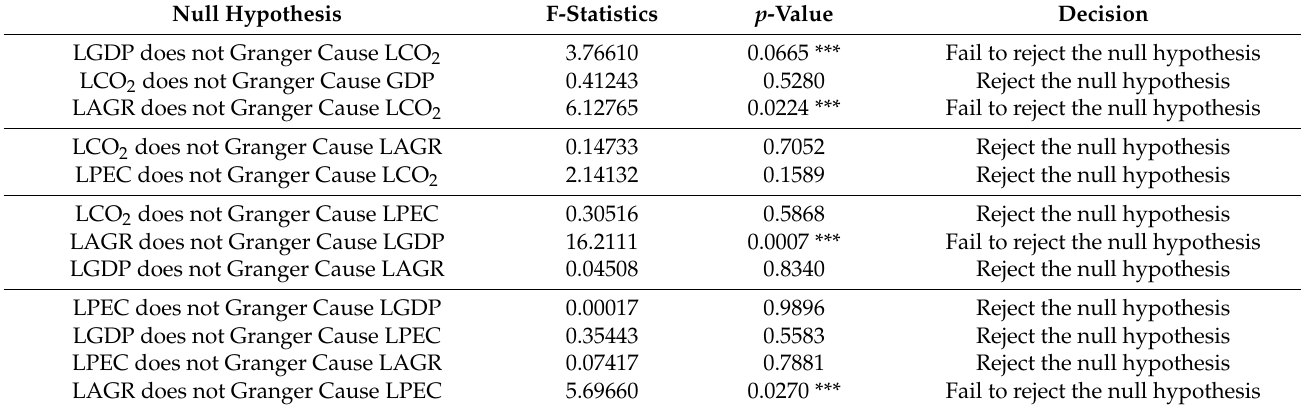
Table 6. Pairwise Granger causality tests.